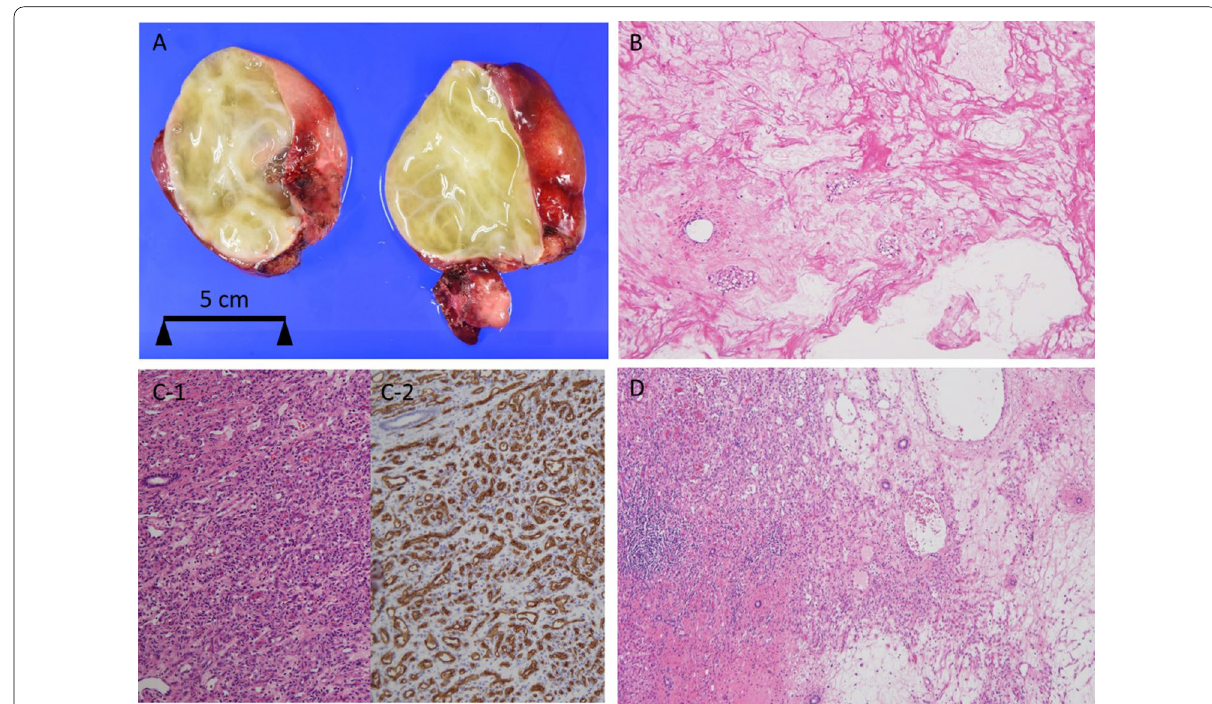
Fig. 3 A Cut section of the cystic lesion in the left lobe revealing spongy, white, and solid components with mucinous material within. B Microscopically, spongy white lesions show loose mesenchymal component with myxoid material, scattered fibroblasts and vessels (hematoxylin and eosin, original magnification 40). C-1 Brownish nodule in non-cystic area showing proliferation of capillaries and small vessels (hematoxylin × and eosin, original magnification 100). C-2 These lesional cells are positive for GLUT-1 by immunostains. D Left area showing IHH and the right × area, HMH; the boundary is obscure (hematoxylin and eosin, original magnification ×